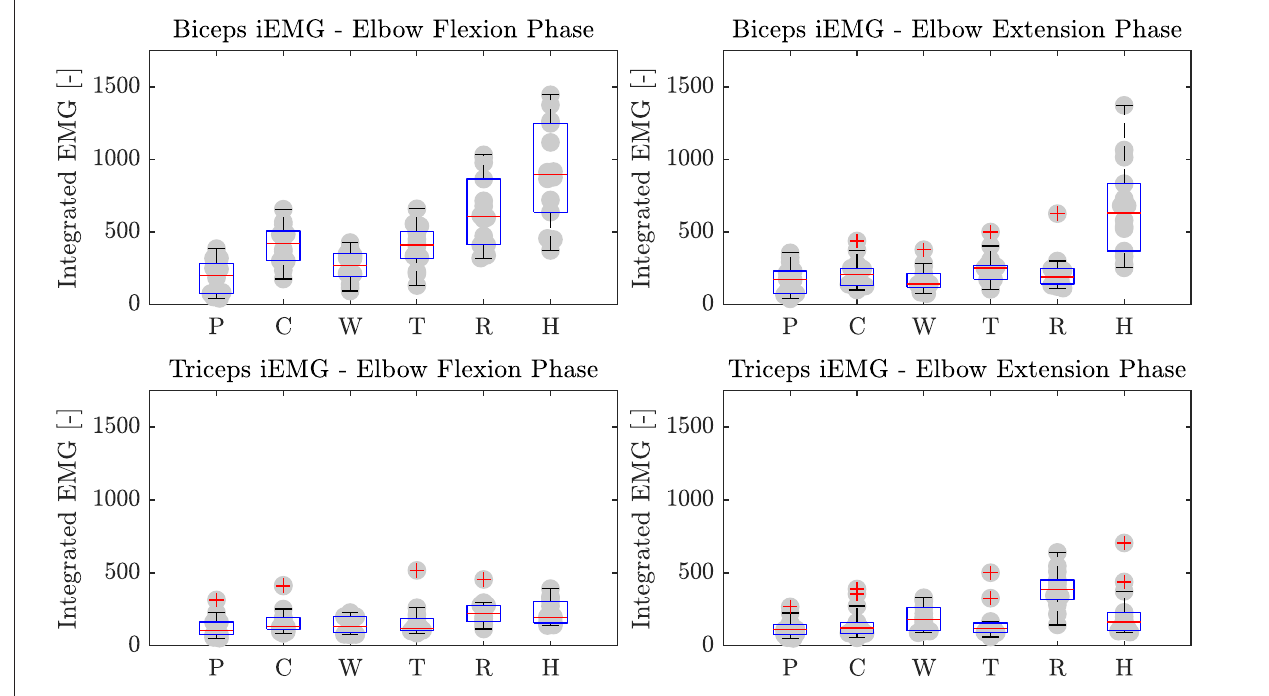
FIGURE 11 | Biceps and triceps brachii iEMG during elbow flexion and extension phases. P, Passive mode; C, Corrective; W, Weight counterbalance; T, Transparent; R, Resistive; H,